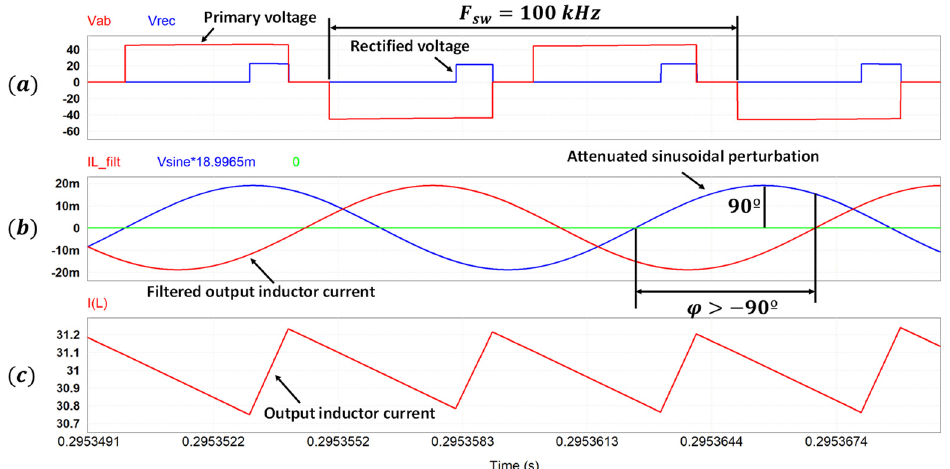
Figure 8. Simulation results of Test 2. ( a ) Primary and rectified voltage. ( b ) Attenuated sinusoidal perturbation and output inductor current after bandpass filter. ( c ) Output filter inductor current.